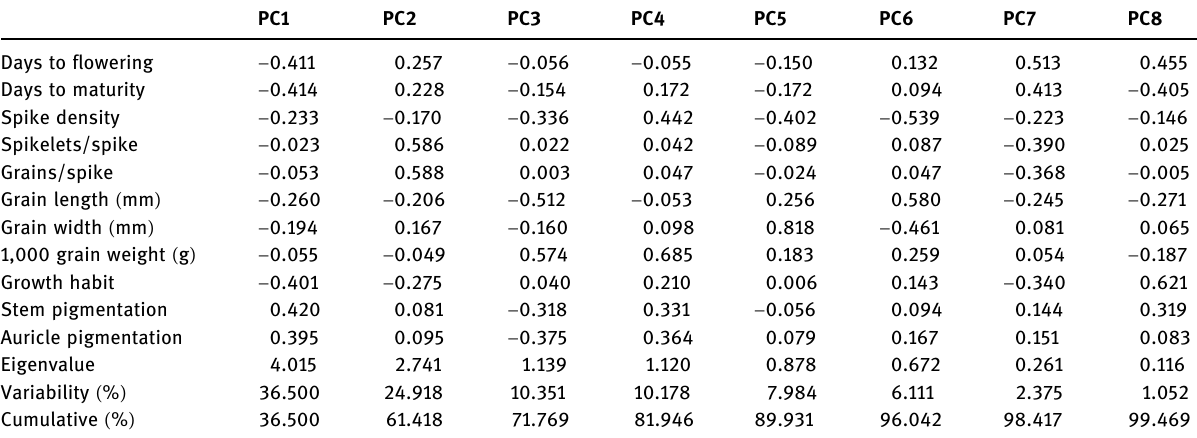
Table 7: Eigenvectors and eigenvalues associated with each character with respect to nine agro - morphological characters and presence/ absence of pigmentation in two plant parts as explained by the fi rst eight principal components ( PC ) in 16 indigenous Hordeum vulgare